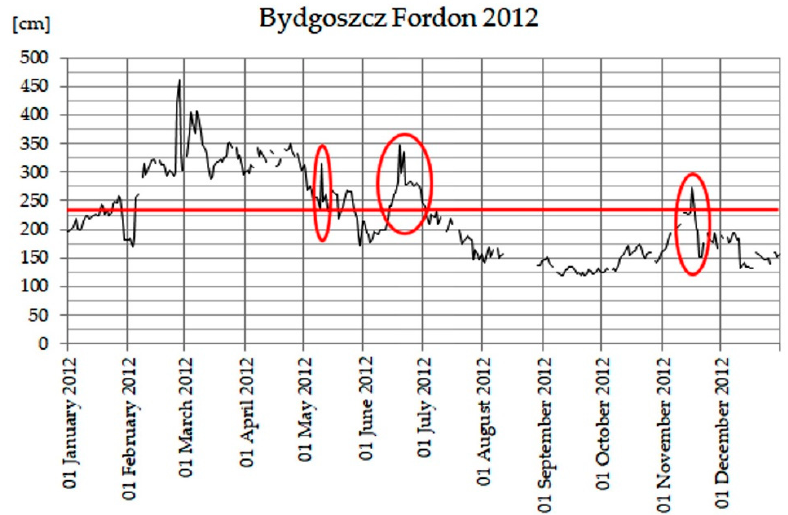
Figure 7. Water levels at the Bydgoszcz Fordon water gauge. Red ellipses—emergency discharge, red line—flooding of the channel bars.